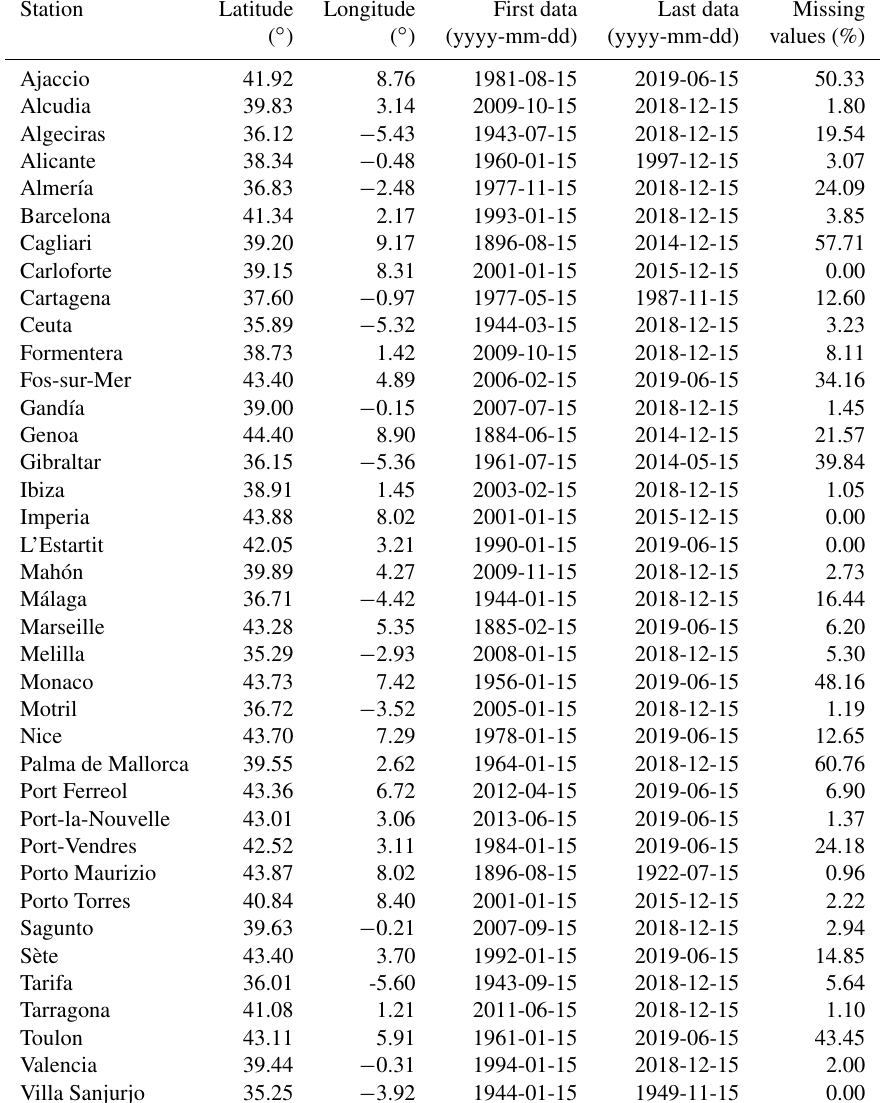
Table 2. PSMSL tide gauges in the western Mediterranean basin, including their location, the start and end dates of the series, and the percentage of missing